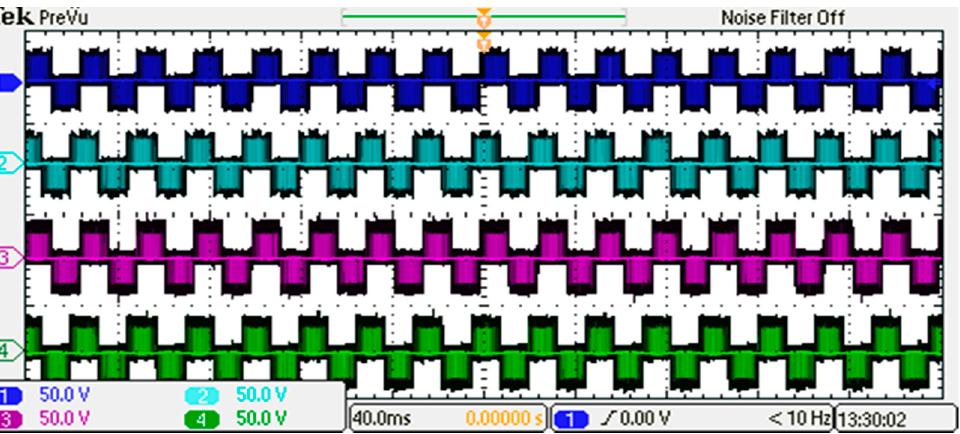
Figure 18. The experimental waveforms of two topologies.